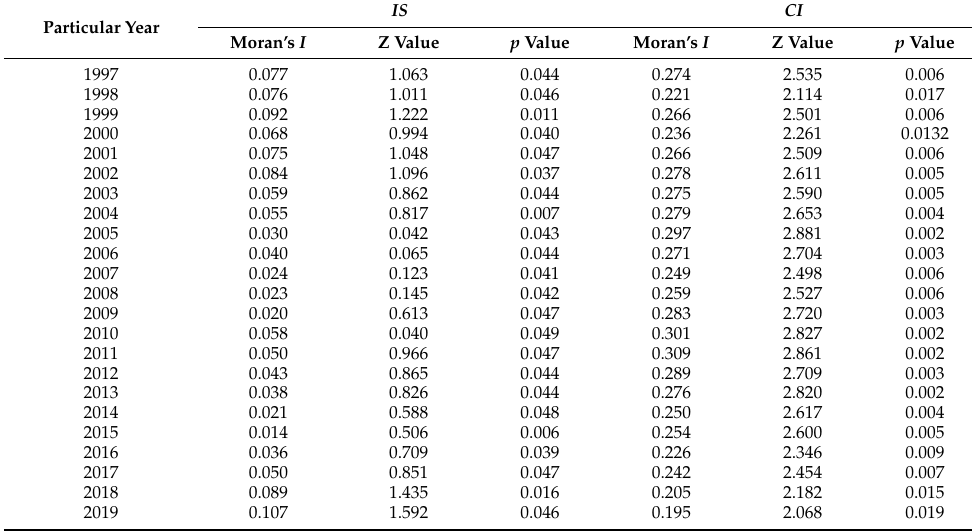
Table 5. Industrial structure upgrading index and global Moran index of carbon emissions from 1997 to